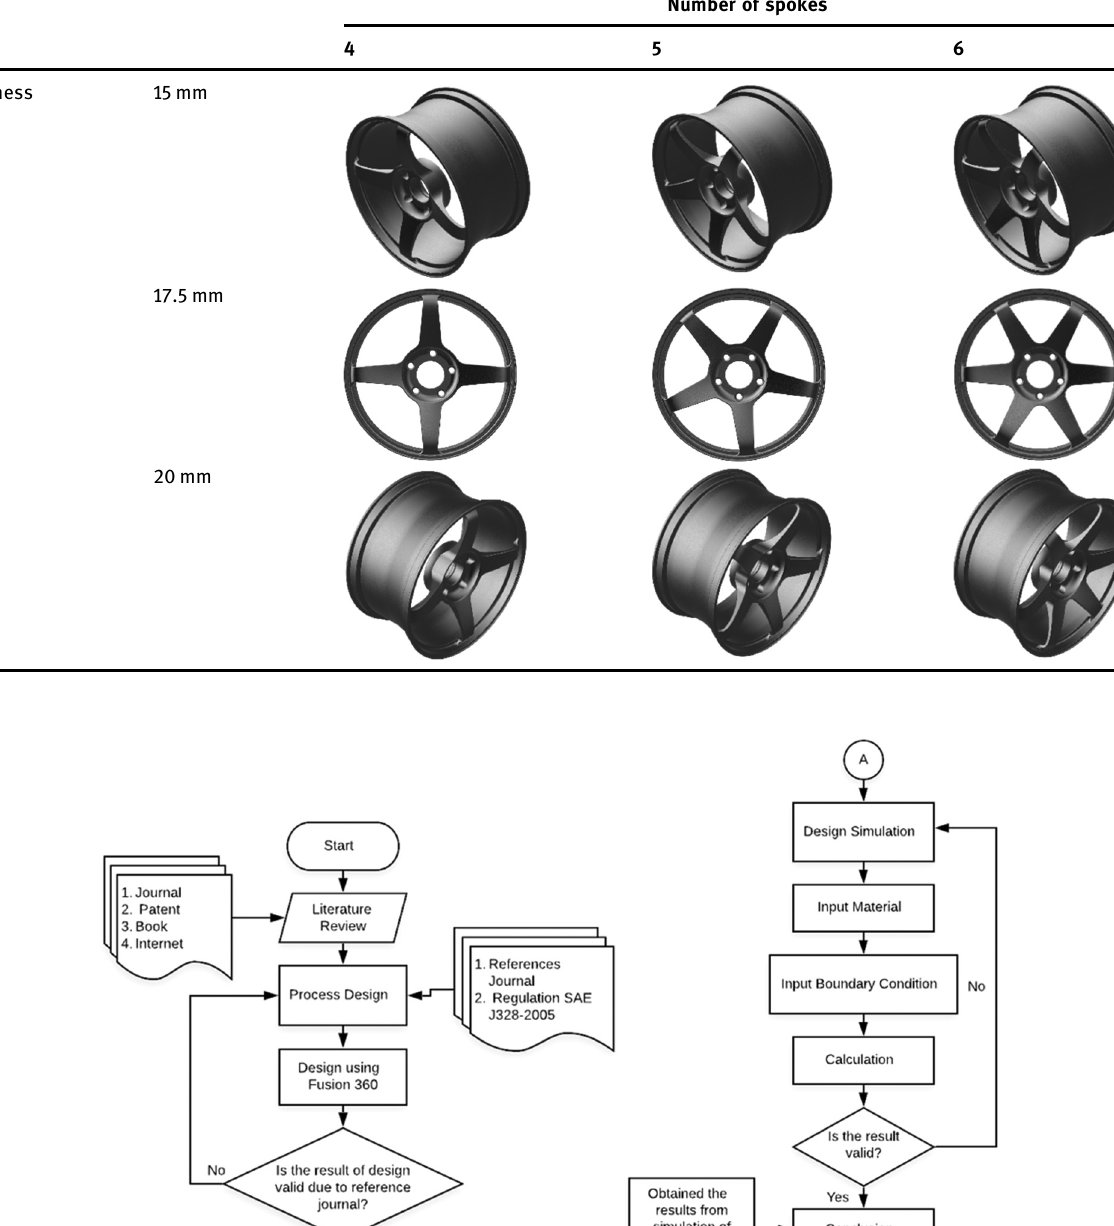
Table 2: Variations in designed rim wheels